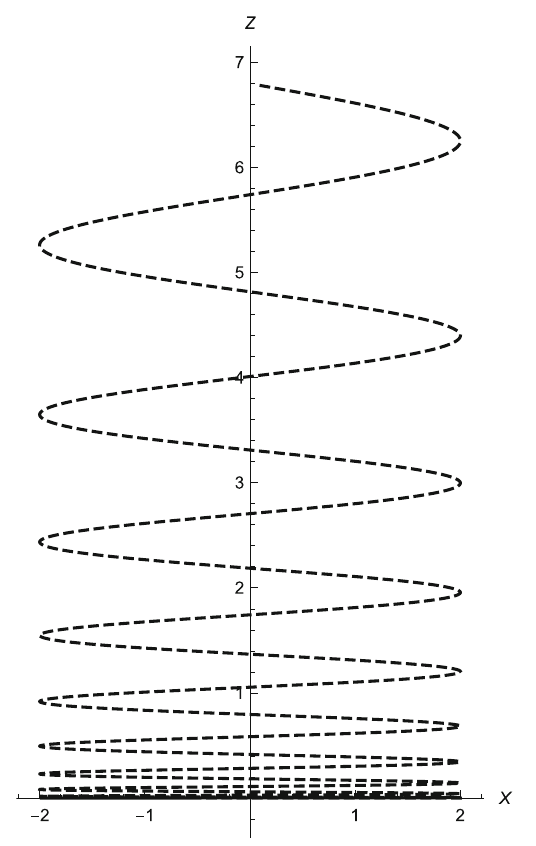
Fig. 5 Trajectory in the XZ plane for β = 1 / 100, b 0 = 1 and n (cid:6) = 4